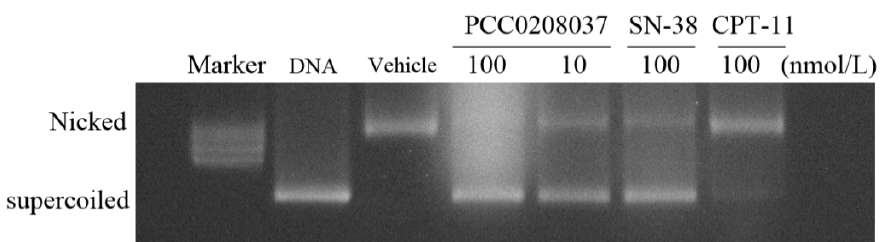
Figure 4. Inhibition of Topo I activity by PCC0208037. Topo I was incubated with the vehicle, 100 and 10 nmol/L PCC0208037, 100 nmol/L SN-38, or 100 nmol/L CPT-11, followed by incubation with supercoiled plasmid DNA. Plasmid DNA was separated by an agarose gel and stained with ethidium bromide.